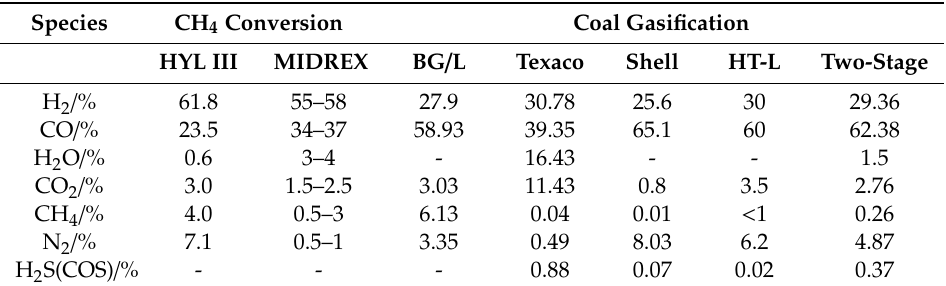
Table 1. The gas composition used for the reduction of iron oxide (volume fraction, %).